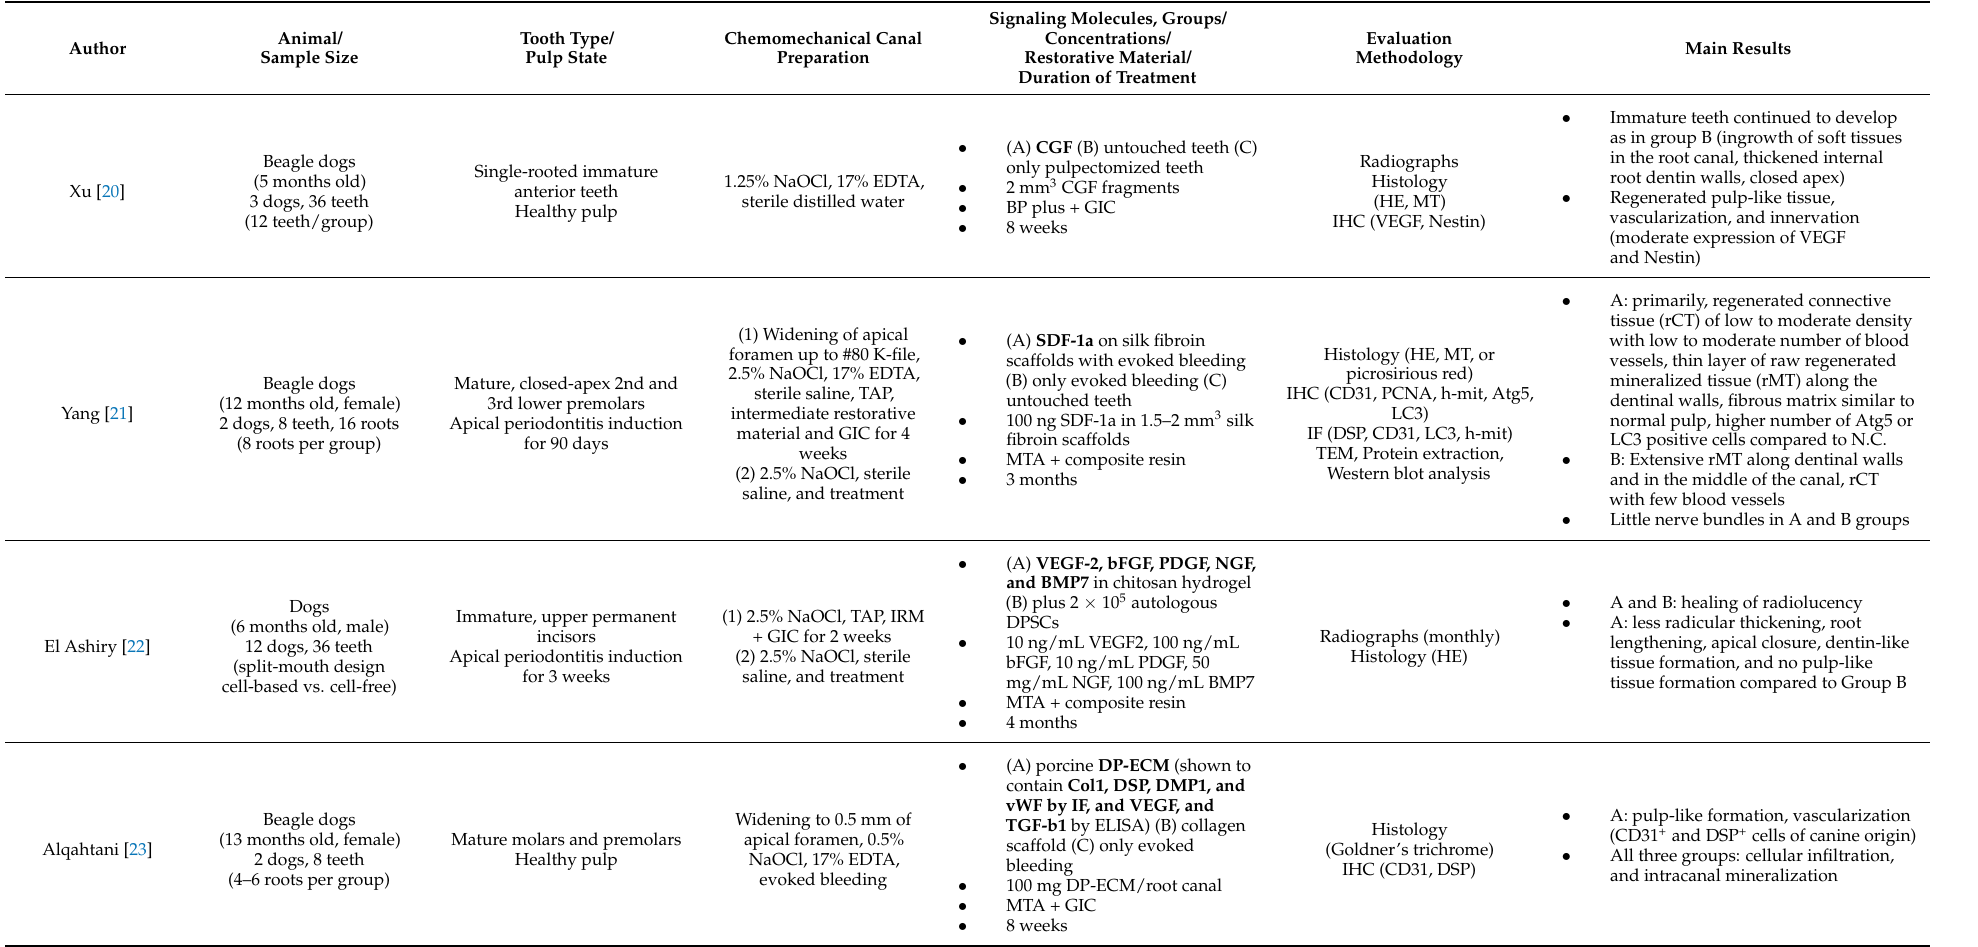
Table 2. Orthotopic animal studies *. The studied signaling biomolecules are indicated in